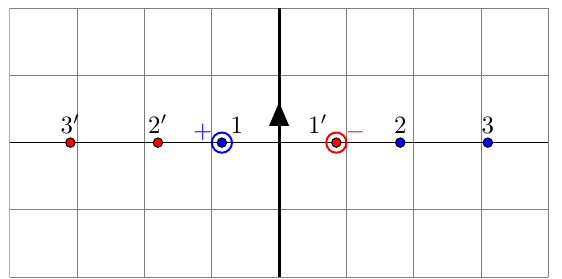
Figure 2 . Choice of contour for a typical CFT correlator in the complex (cid:11) -plane. The blue dots, labeled by 1 ; 2 ; 3 , correspond to physical poles of f ( (cid:11) ), whereas their mirrors (in red, with primed f g labels) are unphysical. The pole 1 has ( (cid:11) ) < 0, hence it corresponds to an operator of dimension < b h < 1 = 2. The contour runs upwards along the imaginary axis, but in this case it must circle 1 in the positive and 1 0 in the negative direction, as